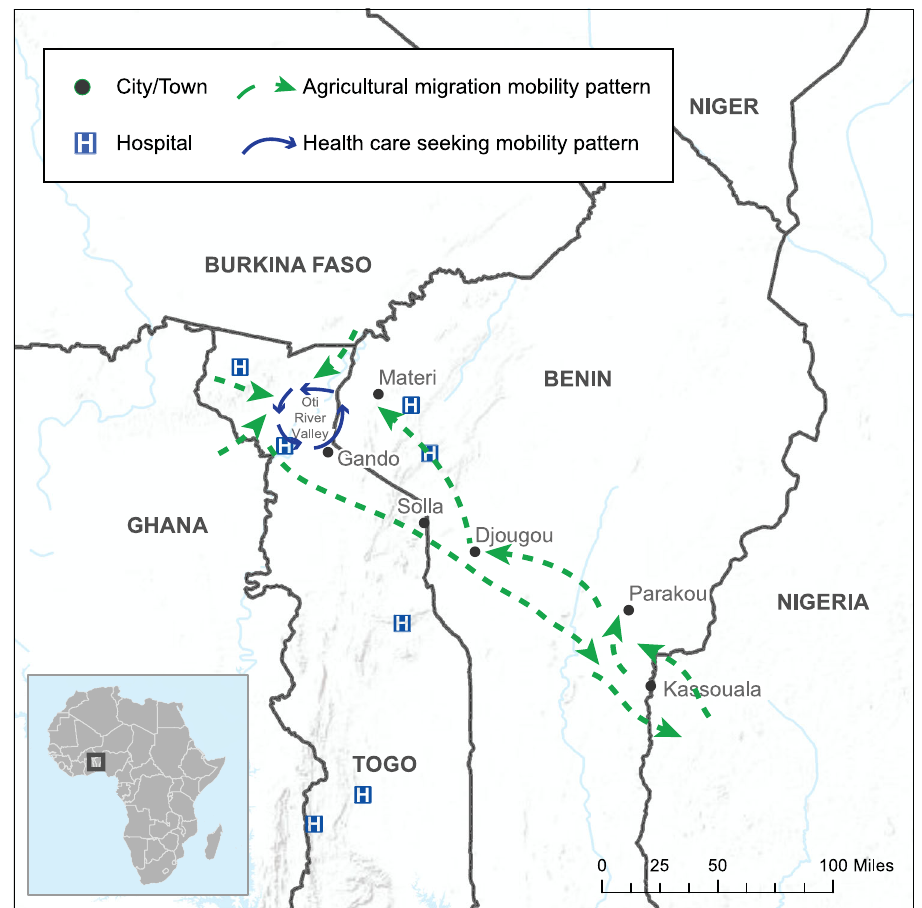
Fig. 3 Example results map from Round 1 Population Connectivity Across Borders (PopCAB) implementation, highlighting two thematic drivers of cross-border mobility patterns. This map re fl ects results from two focus group discussions, one each with participants from Togo and